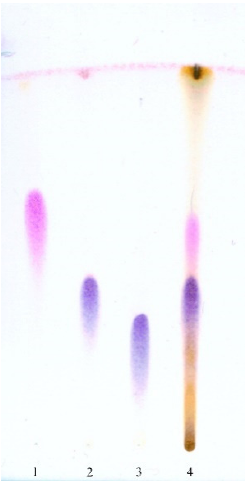
Figure 1. Thin-layer chromatography (TLC) of the purified AcOEt extract and phytoecdysteroids isolated from the S. coronata herb 1. ajugasterone C; 2. 20-hydroxyecdysone; 3. polypodine B; 4. AcOEt extract of the S. coronata herb; adsorbent: silica gel; mobile phase: n-hexane:Me 2 CO 2:1.